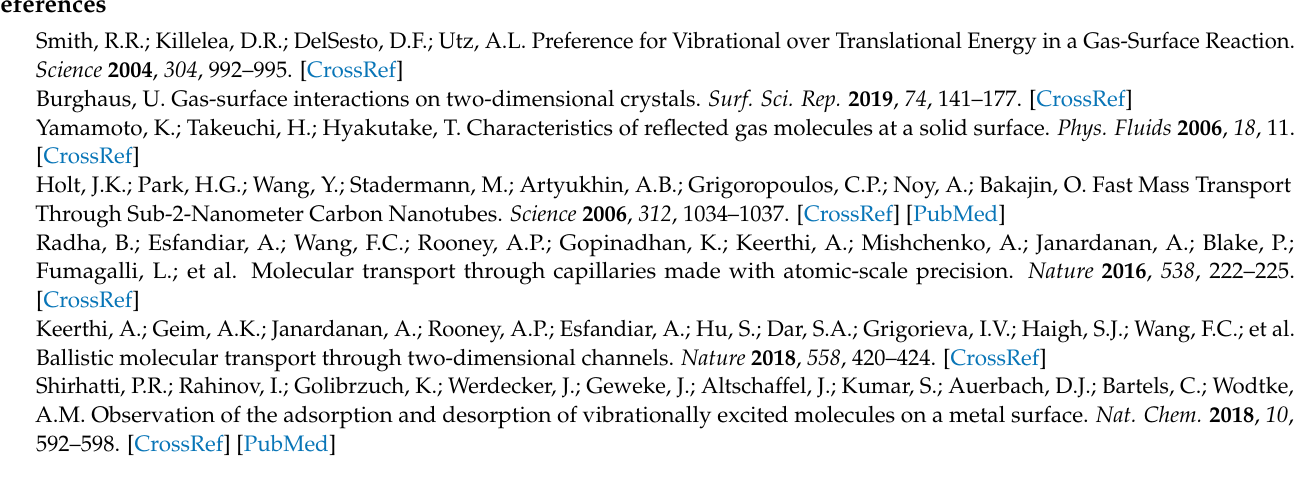
energy in the y–z plane; Figure S4: RNTAC and RTTAC versus zenith angle for various incident helium speeds; Figure S5: Distributions of the speed and velocity components of helium at various